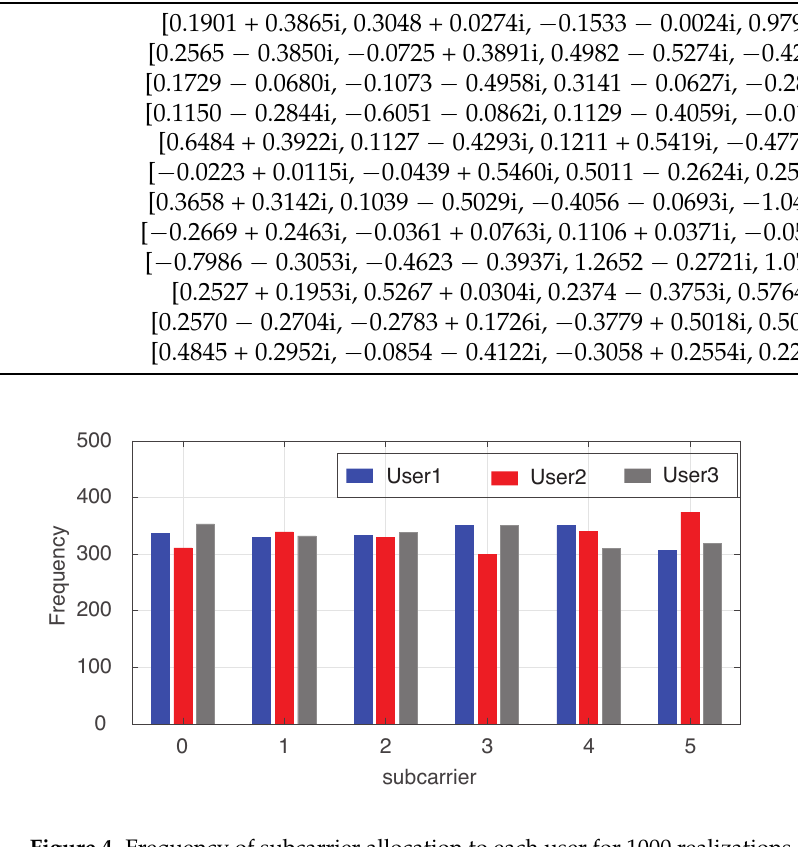
Figure 4. Frequency of subcarrier allocation to each user for 1000